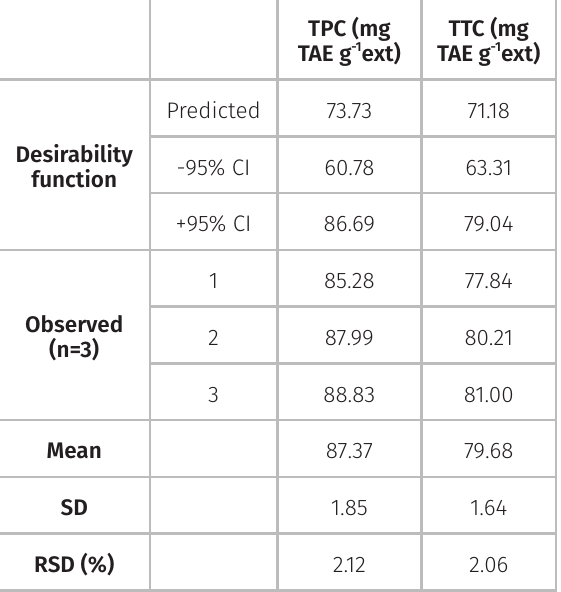
= 0.6 (8 min), X = 1 (300 1 2 = –0.4 (38%). Confidence 4